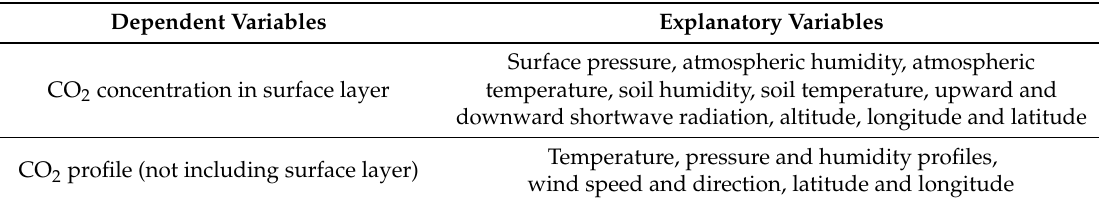
Table 5. Explanatory variables used to model CO 2 in different